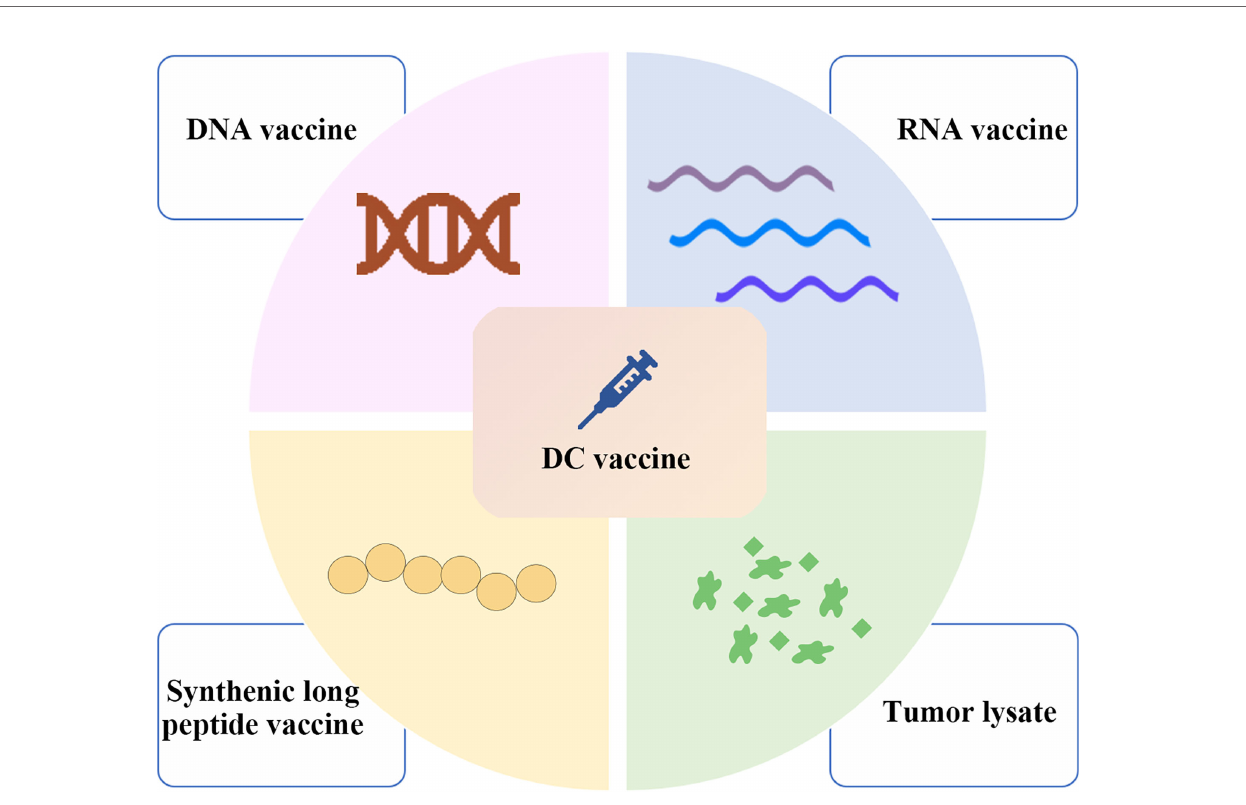
FIGURE 1 | Major types of neoantigen vaccines in clinical research. Neoantigen vaccines mainly include nucleic acid vaccines consisting of DNA and RNA vaccines, synthetic long peptide vaccines and tumor lysate vaccines. In addition to being used separately as vaccines, these neoantigens formulations can also be loaded onto DCs. Therefore, when working with DC vaccines, still the choice needs to be made between loading with either peptides, RNA, DNA or tumor